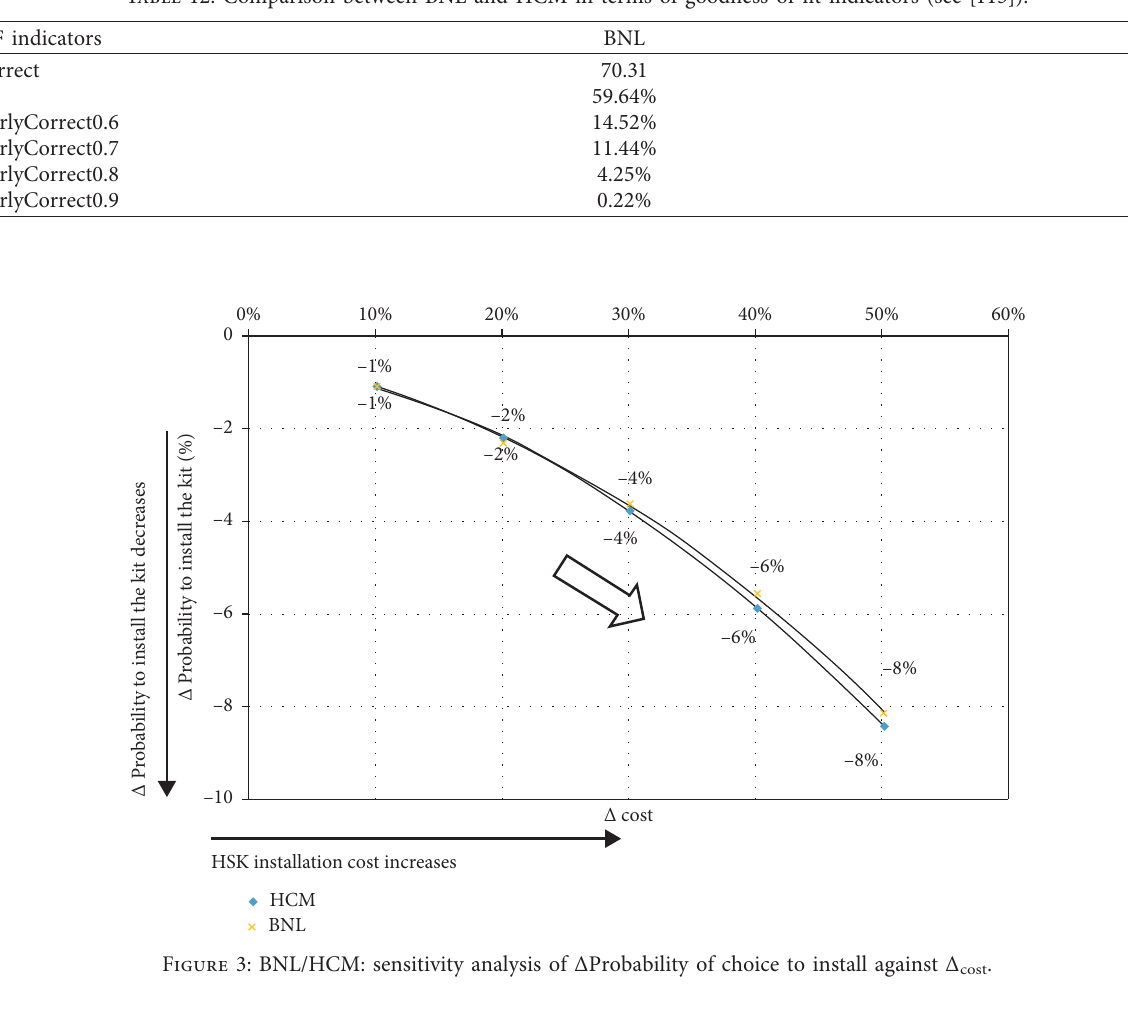
Table 12: Comparison between BNL and HCM in terms of goodness-of-fit indicators (see [115]).